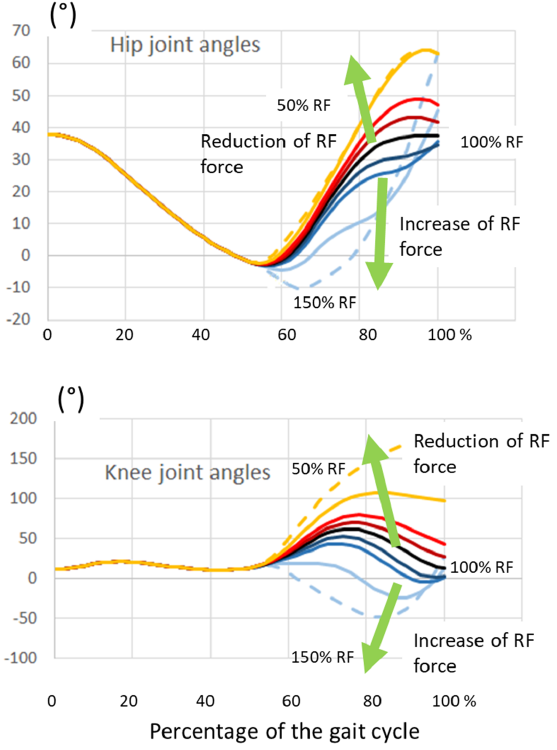
Figure 5. Left: kinematics resulting from decreasing RF force; right panel: kinematics resulting from increasing RF force. The model is represented in the position achieved at the end of stride time (100% stride time). The red and blue curves represent the trajectory of a point located on the heel of, respectively, the right side (una ff ected, blue line) and the left side (our test limb, red line). The hip joint flexion was not imposed (no compensation for RF force changes).